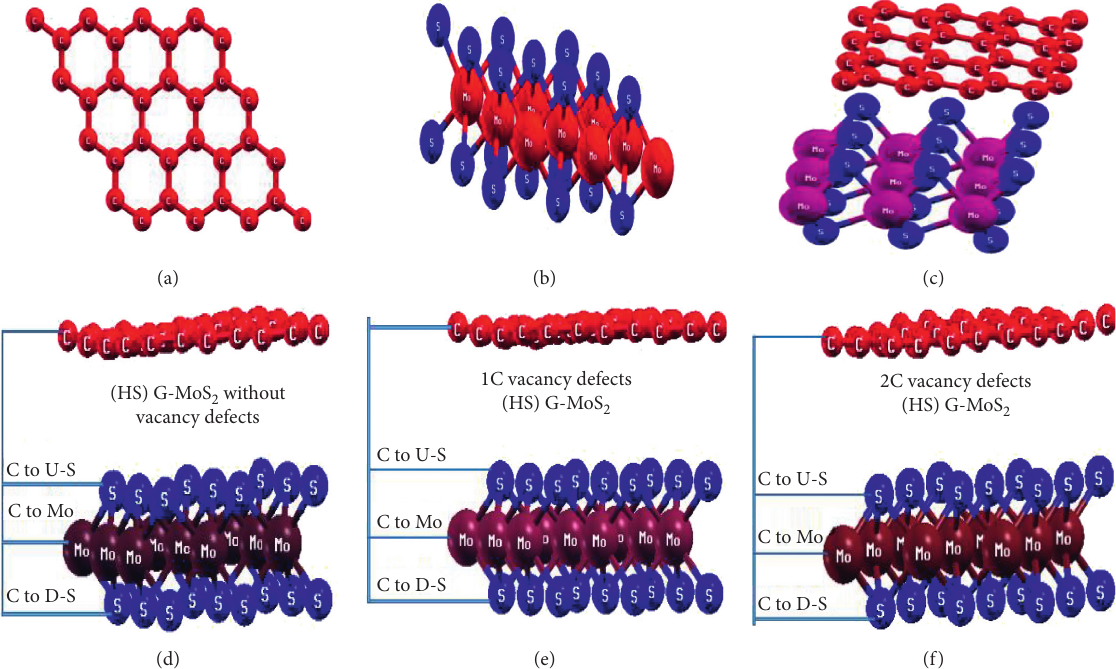
Figure 1: (a) (4 × 4) supercell structure of Graphene. (b) (3 × 3) supercell structure of MoS and interatomic distances measurement geometry of HS-G/MoS 2 . (e) Interlayer and interatomic distances measurement geometry of 1C atom vacancy defects in HS-G/MoS 2 . (f) Interlayer and interatomic distances measurement geometry of 2C atom vacancy defects in HS-G/ MoS 2